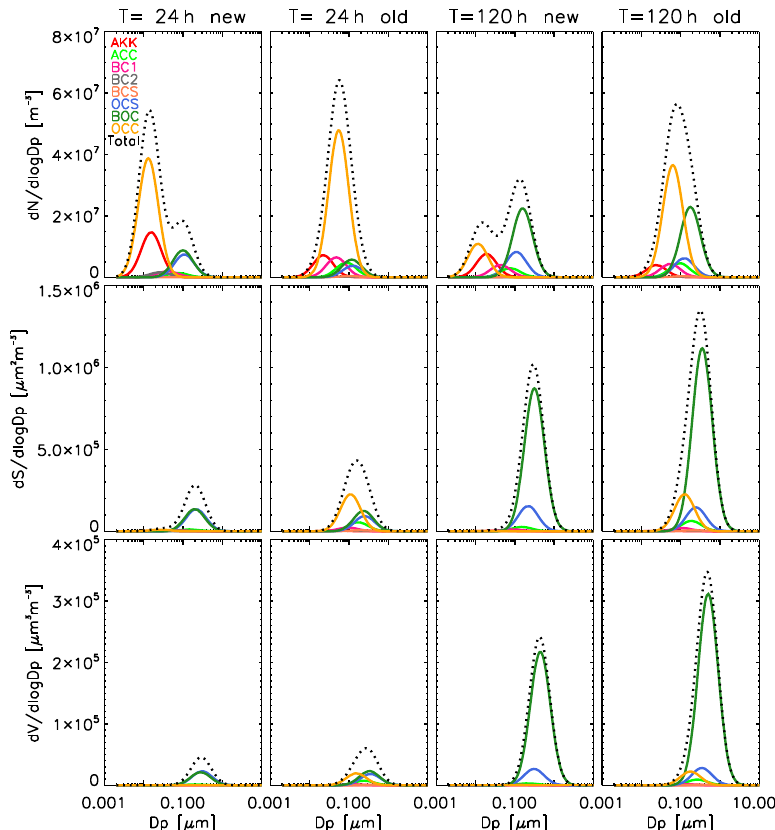
Figure 6. Organics-containing aerosol populations (except MXX) and AKK (Aitken mode sulfate) size distributions for Mexico City in January. Top row: number concentration. Middle row: surface area. Bottom row: volume. Total of all populations in dotted black lines.